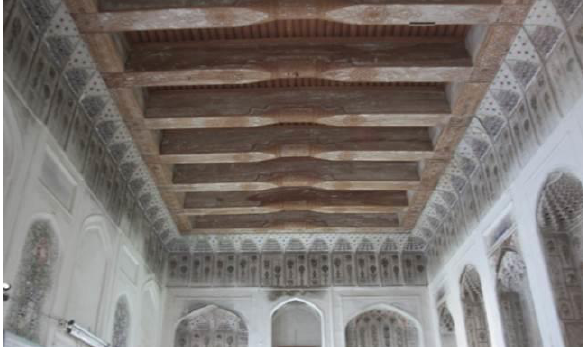
Figure 5. Ceiling beams in a traditional Bukharian house.